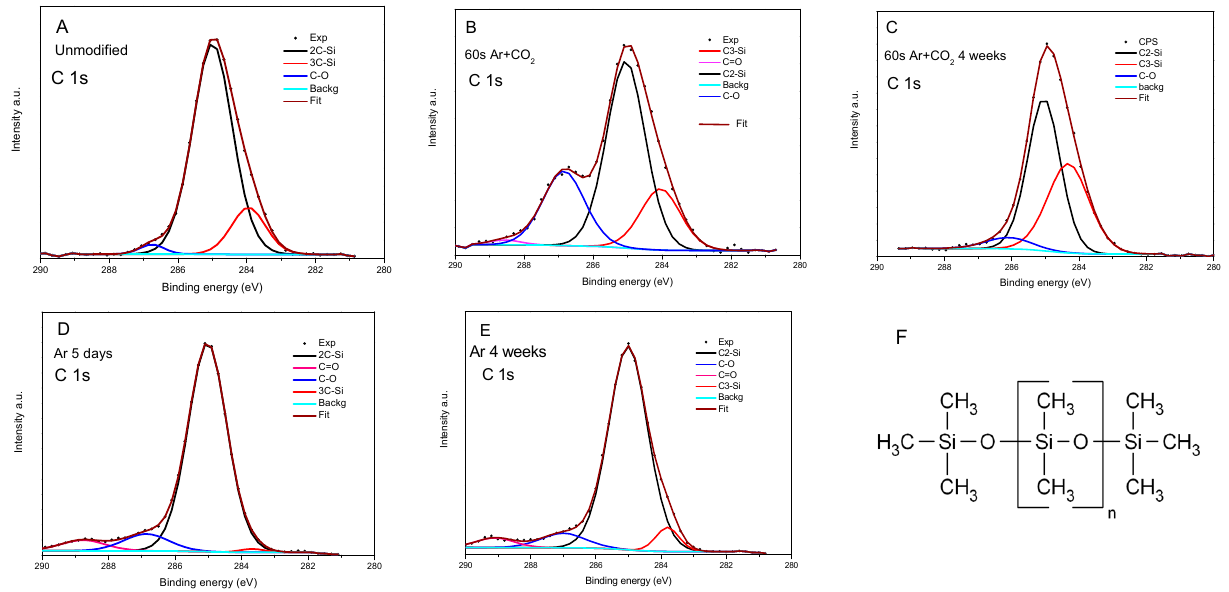
Figure 6. XPS 1s C spectra: ( A )—unmodified silicone, ( B )—directly after modification in Ar + CO 2 for the 60 s, ( C )—after four weeks, ( D )—5 days after modification in Ar, ( E )—after four weeks, ( F )—chemical formula of silicone, where n is the number of repeating monomer. Much fewer changes in rubber bonds chemistry were observed in modifying in Ar only. Small increases in the limit of errors (from 1.19 to 1.22) after four weeks were observed in the O/Si ratio, and a slight decrease (from 2.04 to 1.93) in the C/Si ratio. However, in both cases, it is a considerable increase compared to pristine rubber. Therefore, the rubber was modified, but after five days, it was stable. Moreover, we did not observe a significant rise in the number of 3C-Si-O bonds, so the polymer molecule was not destroyed much, and not as much as when Si-O/OH bonds were formed. In summary, XPS studies confirm the formation of C-O, C=O, and Si-O/OH groups after modification. These groups were more stable in the case of Ar plasma